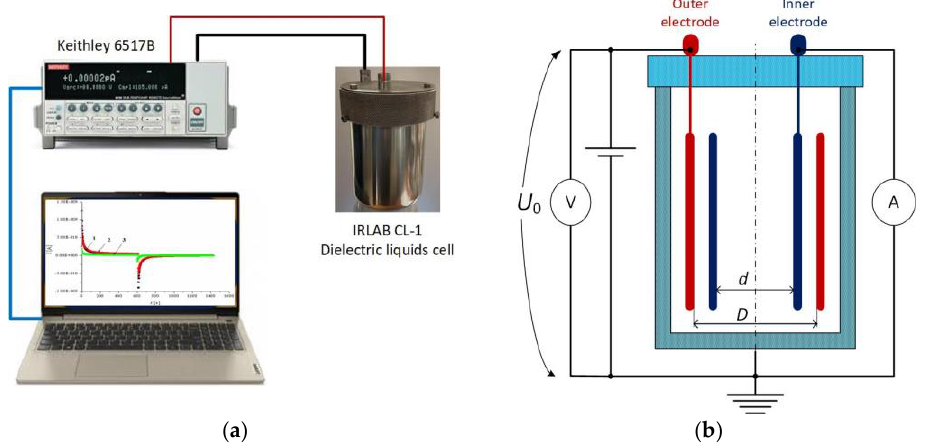
Figure 4. ( a ) Experimental setup used for measuring the absorption and the resorption currents; ( b ) schematic view of the IRLAB CL-1 measurement cell for dielectric liquids. ( b ) schematic view of the IRLAB CL-1 measurement cell for dielectric